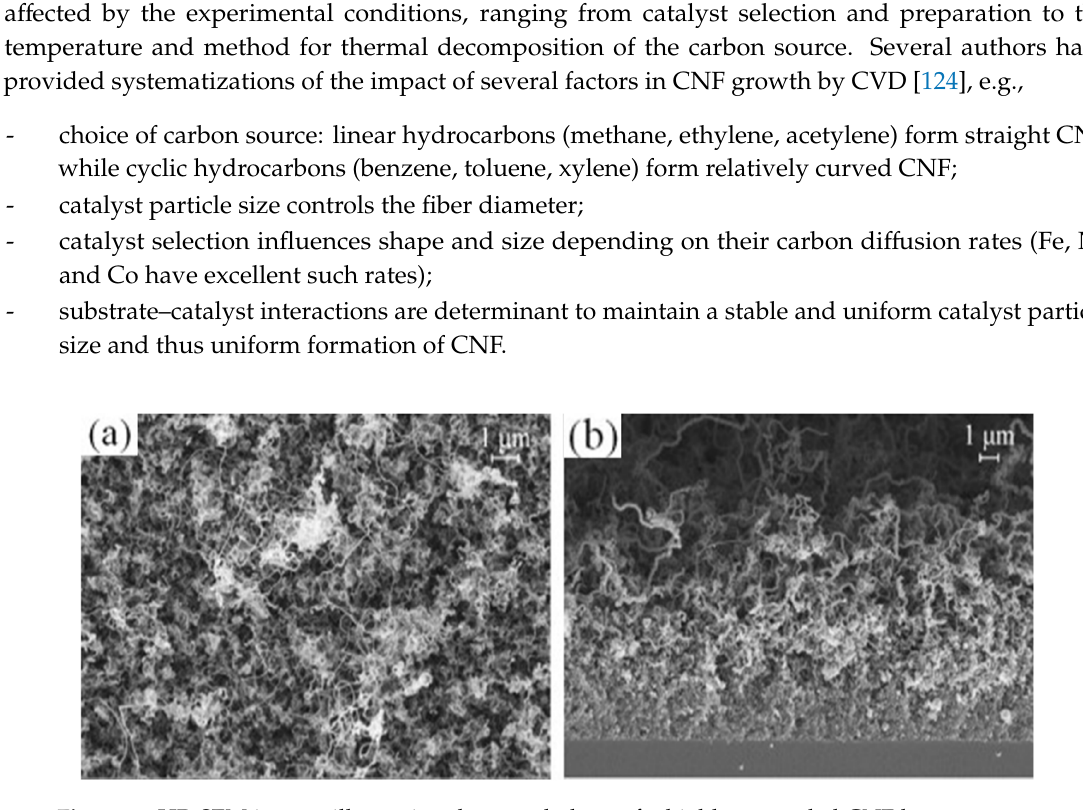
Figure 6. HR-SEM images illustrating the morphology of a highly-entangled CNF layer grown on 25 nm Ni and 10 nm Ta on oxidized silicon: ( a ) top-view; ( b ) cross-sectional view [117].